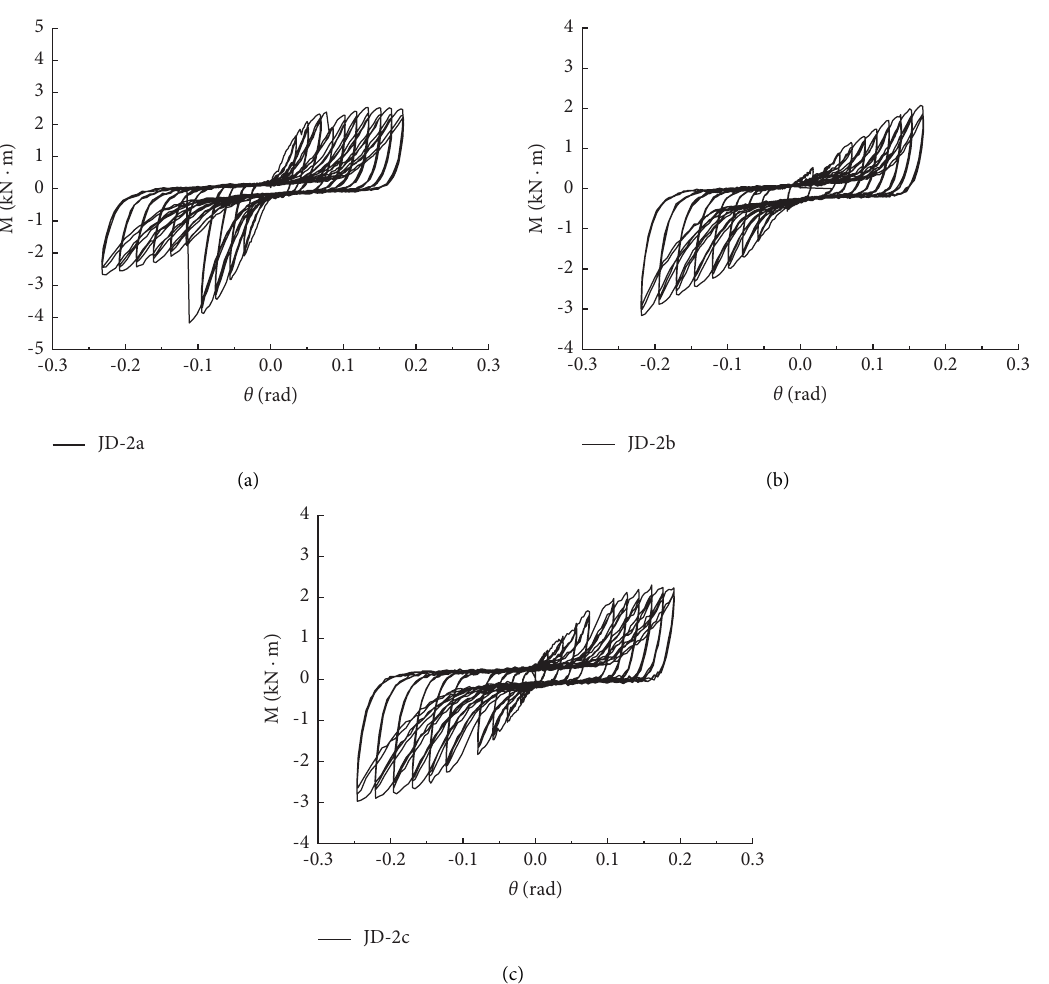
Figure 9: Moment-rotation hysteretic loops after reinforcement with steel plate: (a) Tou mortise-tenon joints. (b) Ban mortise-tenon joints. (c) Dovetail mortise-tenon